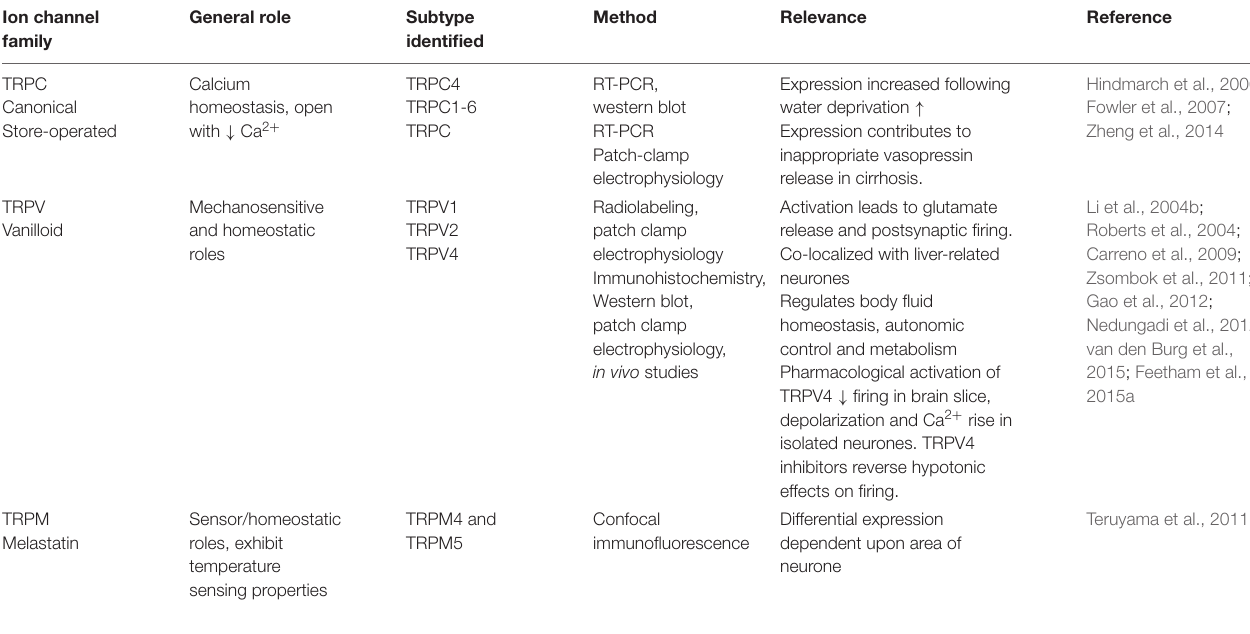
TABLE 2 | TRP channels in the